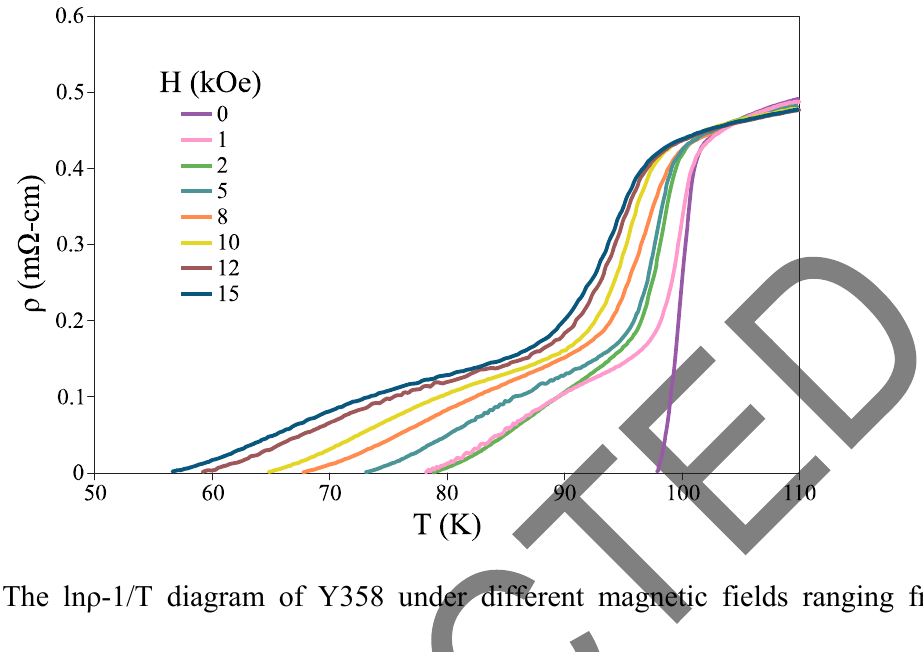
Figure 2. The ln ρ -1/T diagram of Y358 under different magnetic fields ranging from 0–15